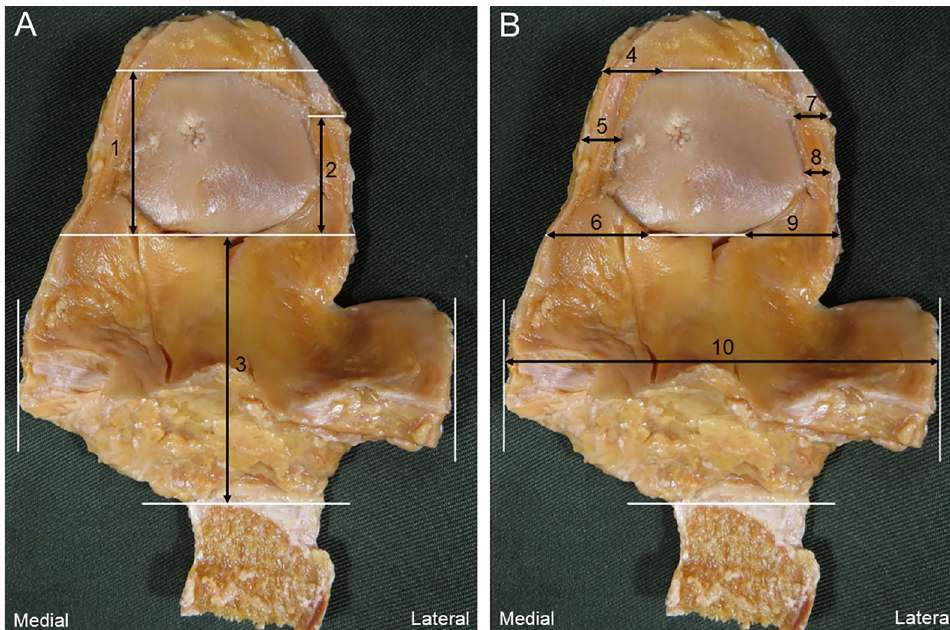
Figure 4. Measurement of the infrapatellar fat pad; right knee, posterior view. ( A ) Length of the infrapatellar fat pad superior medial extension and superior lateral extension, infrapatellar fat pad body. ( B ) Width of the infrapatellar fat pad superior medial extension and superior lateral extension, infrapatellar fat pad body. Black arrow 1: In cases with the infrapatellar fat pad superior medial extension connecting to the suprapatellar fat pad. Black arrow 2: In cases with the infrapatellar fat pad superior lateral extension not connecting to the suprapatellar fat pad. Black arrow 3: Infrapatellar fat pad body. Black arrow 4: Infrapatellar fat superior medial extension top. Black arrow 5: Infrapatellar fat superior medial extension center. Black arrow 6: Infrapatellar fat superior medial extension end. Black arrow 7: Infrapatellar fat superior lateral extension top. Black arrow 8: Infrapatellar fat superior lateral extension center. Black arrow 9: Infrapatellar fat superior lateral extension end. Black arrow 10: Infrapatellar fat pad body. White line: Reference